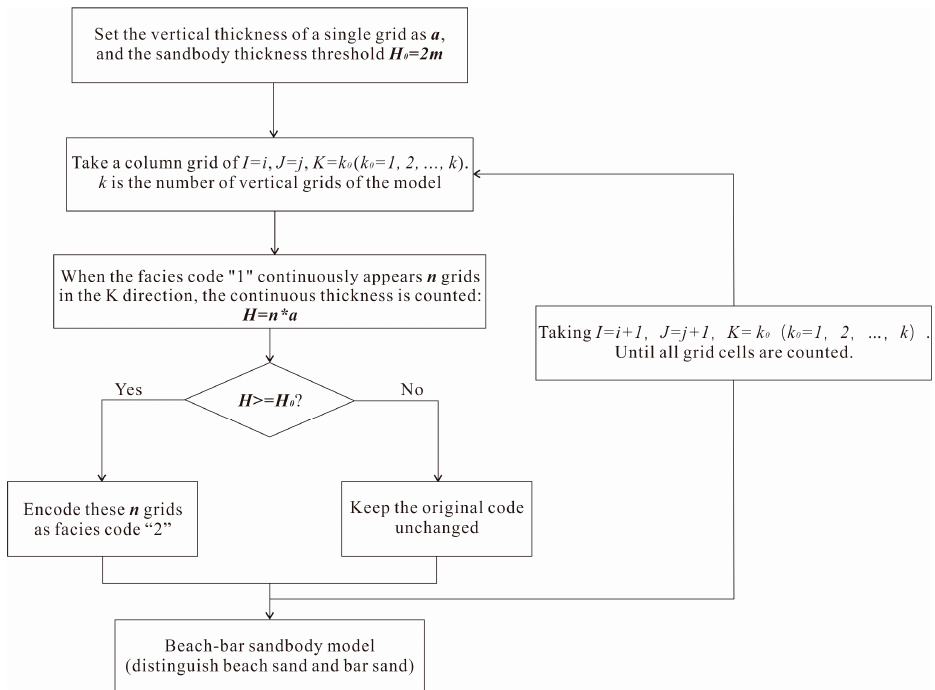
Figure 10. Algorithm flow of distinguishing between beach sand and bar sand according to continuous thickness.